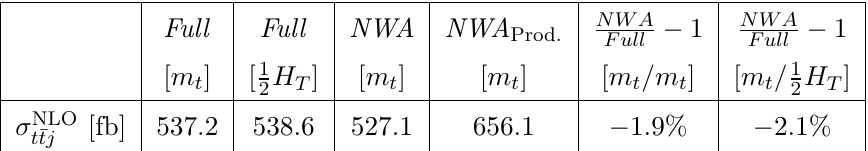
Table 2 . Integrated NLO cross sections for the pp e + (cid:23) e (cid:22) (cid:0) (cid:22) (cid:23) (cid:22) b (cid:22) bj + X production process at the ! LHC with p s = 13 TeV. Results are evaluated using (cid:22) R = (cid:22) F = (cid:22) 0 , where (cid:22) 0 = m t or (cid:22) 0 = H T = 2. The CT14 PDF set and m t = 173.2 GeV are used. In the last two columns the combined relative size of o(cid:11)-shell e(cid:11)ects of t and W is also